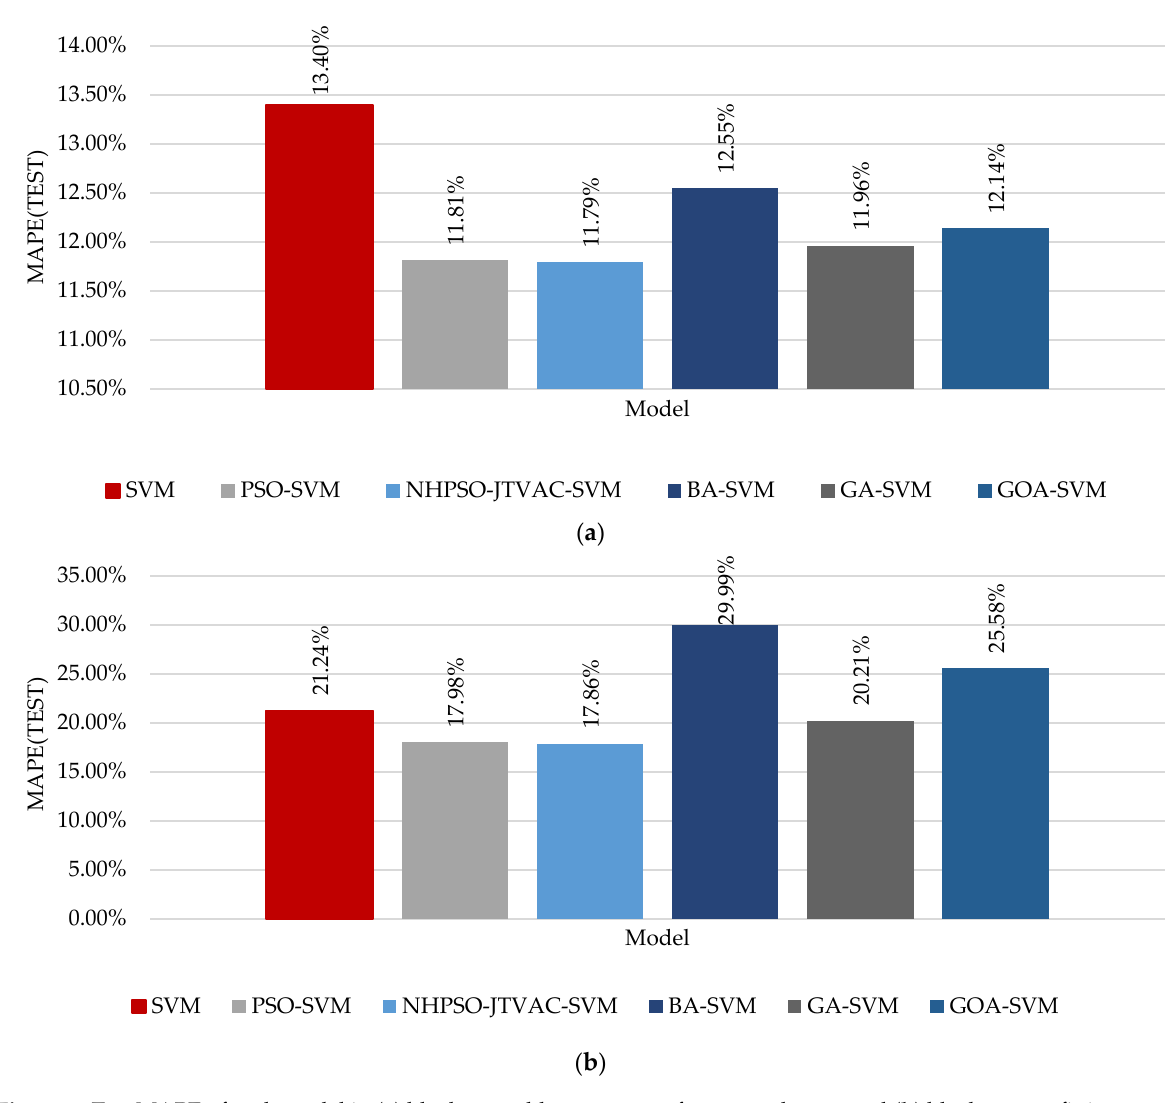
Figure 8. Test MAPE of each model in ( a ) block assembly process performance dataset and ( b ) block pre-outfitting process performance dataset. Table 6. Optimal values of the three SVM parameters ( 𝐶 , 𝜀 , and 𝜎 ).